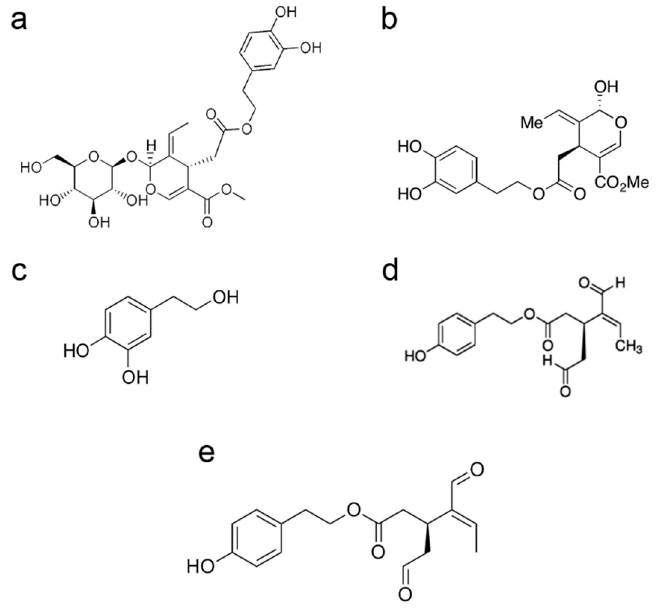
Figure 1. Chemical structure of oleuropein ( a ), oleuropein aglycone ( b ), hydroxytyrosol ( c ), oleacein ( d ), oleocanthal ( e ).